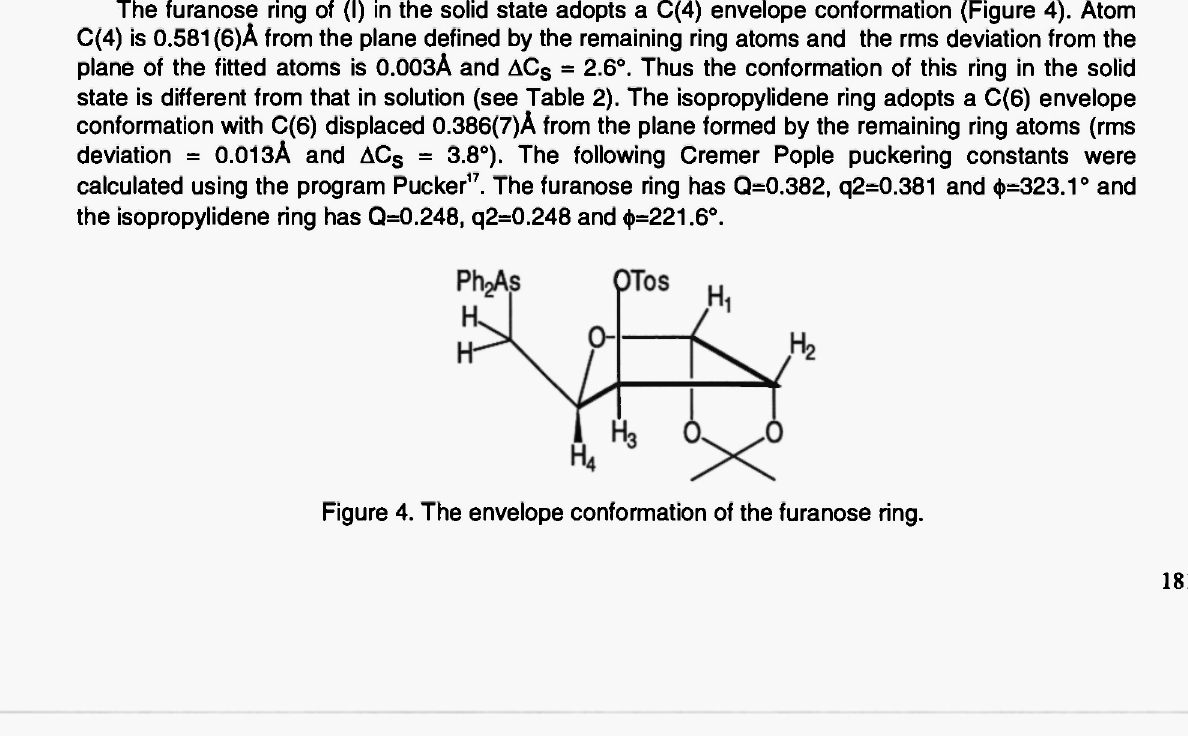
Figure 4. The envelope conformation of the furanose